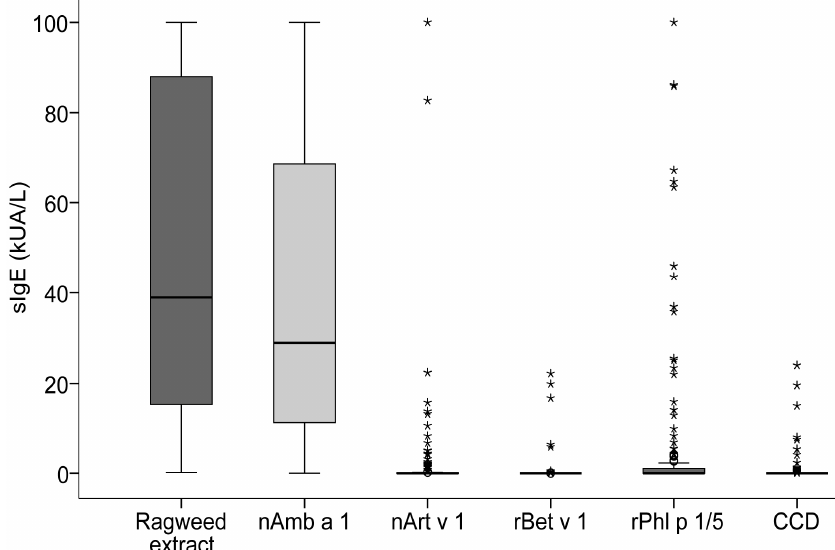
Figure 1. Box plot representation of specific IgE levels tested in ImmunoCAP (median = horizontal bars, boxes = interquartile range (IQR), whiskers = minimum and maximum not exceeding IQR; asterisks represent outliers exceeding 3.0 x IQR) against ragweed and other relevant pollen allergens (x-axis) in the study cohort ( n = 150). Results are expressed as kUA/L (y-axis). 2.3. IgE-Specific for nAmb a 1 Accounts for More Than 50% of Ragweed Pollen sIgE in the Ma- jority of Ragweed Pollen Allergic Patients Different levels of sIgE towards nAmb a 1 in the extract are displayed in Figure 2. In this analysis, 19% of the patients ( n = 29) had more nAmb a 1 sIgE compared to extract sIgE, 37% of the patients ( n = 56) had nAmb a 1 sIgE between 81 and 100%, 31% of the patients ( n = 46) had nAmb a 1 sIgE between 51 and 80%, 9% of the patients ( n = 13) had nAmb a 1 sIgE between 11 and 50% and 4% patients ( n = 6) had sIgE against nAmb a 1 up to 10%, compared to extract sIgE.